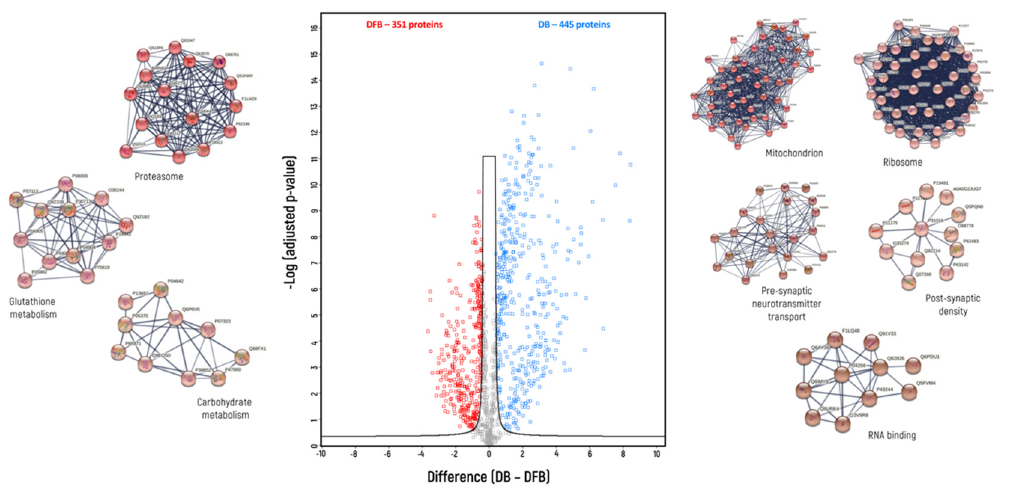
Figure 2. Volcano plot of proteins for which different levels were found between DB and CAB ho- mogenization buffers (blue—overrepresented in DB buffer; green—overrepresented in CAB buffer); indicated are protein clusters which were identified by GO analysis with application of Markov clustering method (FDR < 0.01).